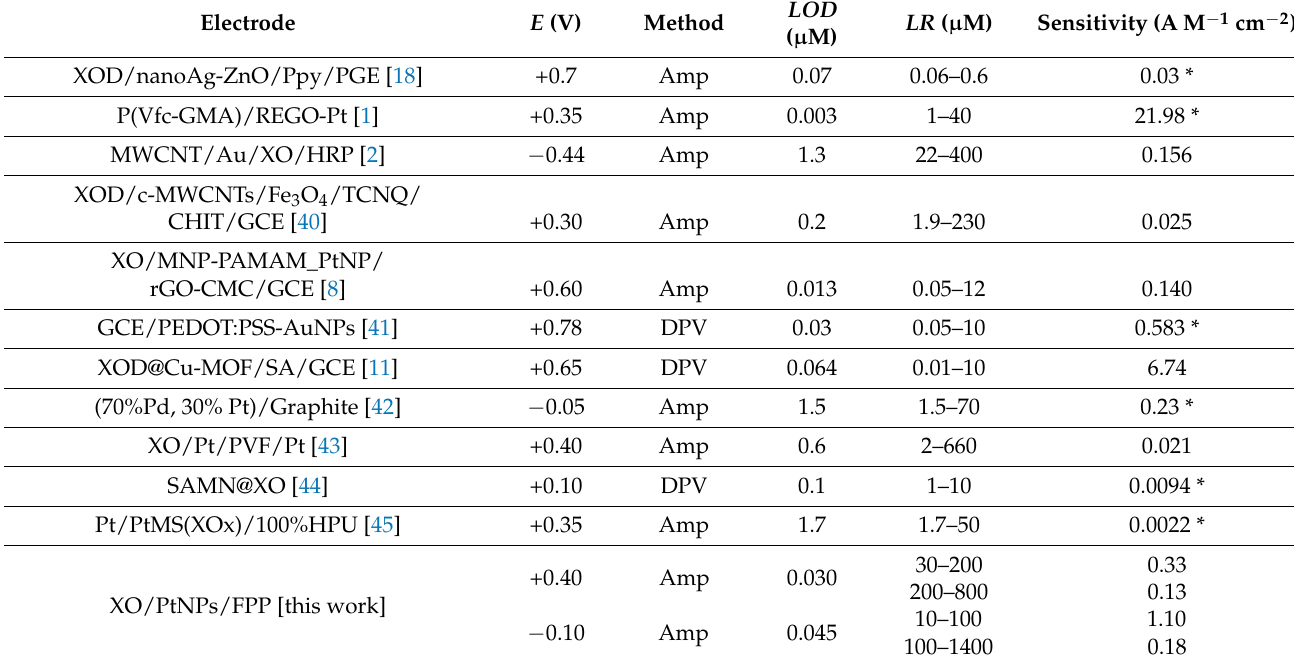
Table 4. Comparison of analytical characteristics of some electrochemical xanthine